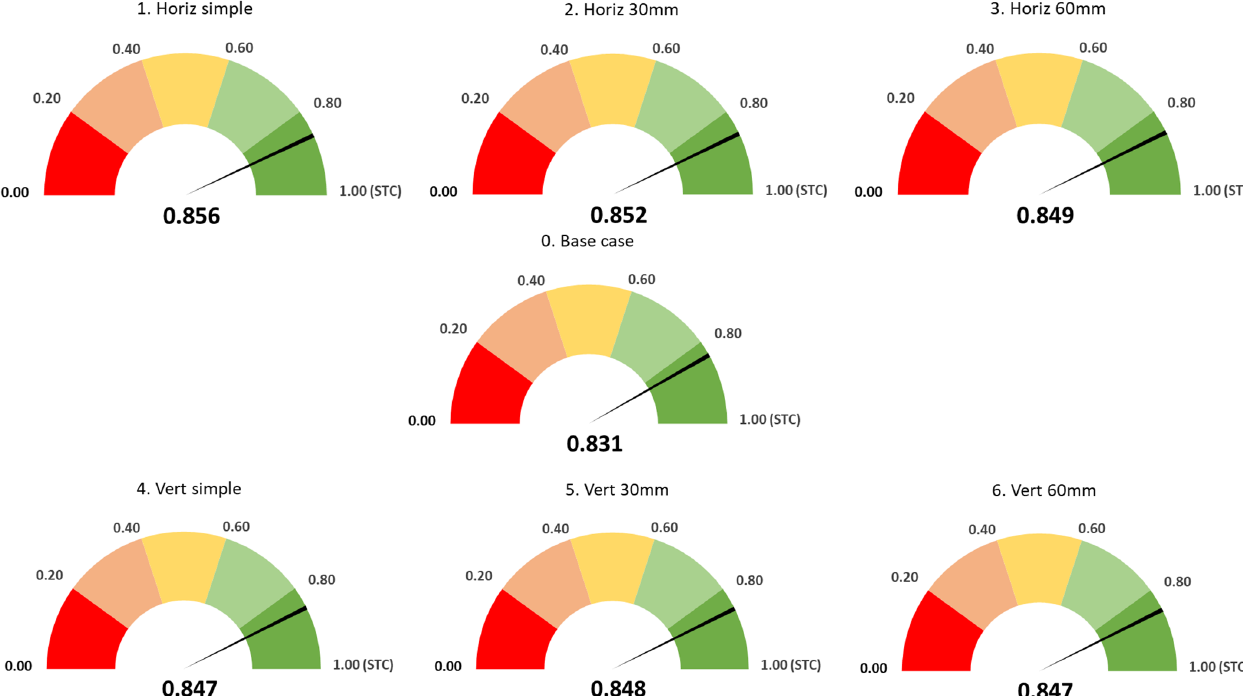
Figure 12. Normalized power production for front wind , v front = 1 m/s, t air = 35, G = 1000 W/m 2. Even if the highest energy production is obtained in the case of the wind direction behind the panel, for the horizontal heat sink with perforated fins, it should be specified that the most important impact in terms of cooling compared to the base case is recorded when the wind blows from the side.